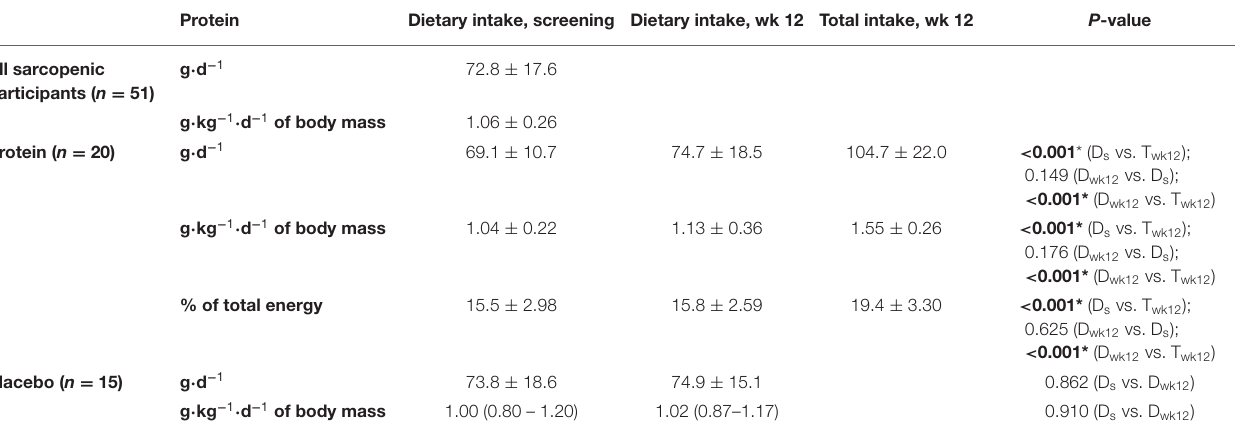
TABLE 3 | Protein intake (mean ± SD) based on the four-day EDR of all community-dwelling (pre)sarcopenic older adults and subgroups of n = 20 receiving protein supplement and n = 15 receiving placebo supplements. Protein Dietary intake, screening Dietary intake, wk 12 Total intake, wk 12 P -value